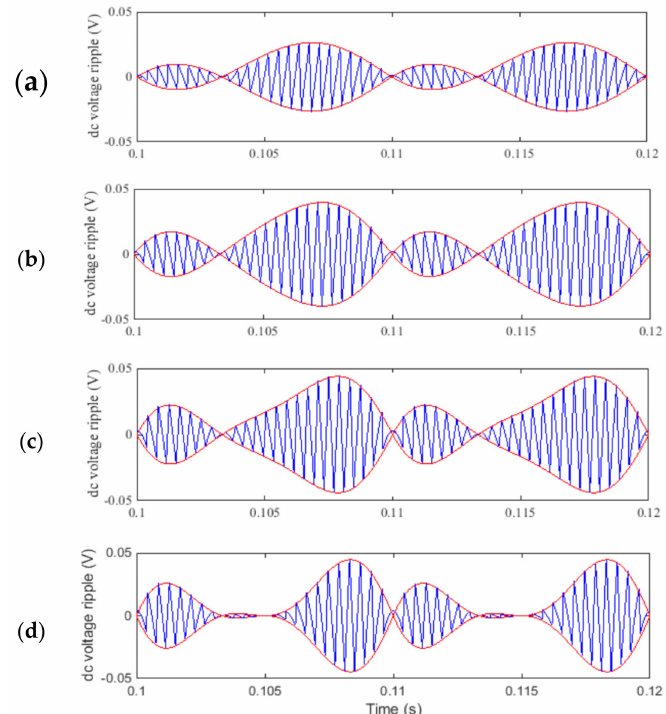
Figure 9. DC-link voltage switching ripple: simulation results (blue trace) and theoretical peak-to-peak envelope (red trace) over a fundamental period for ϕ = 60 ◦ , ( a ) m = 0.25; ( b ) m = 0.5; ( c ) m = 0.75; and ( d ) m =